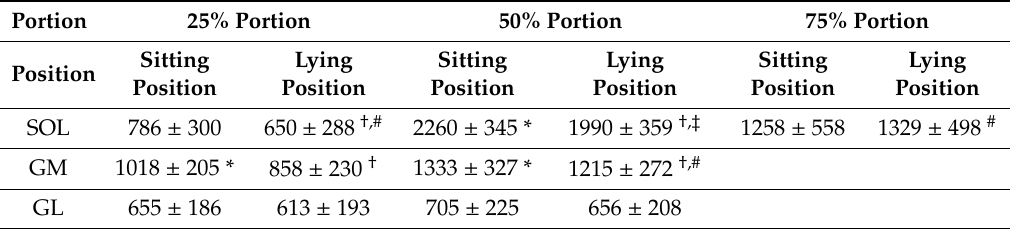
Table 1. Muscle cross-sectional area in the sitting and lying positions (cm 2 ).